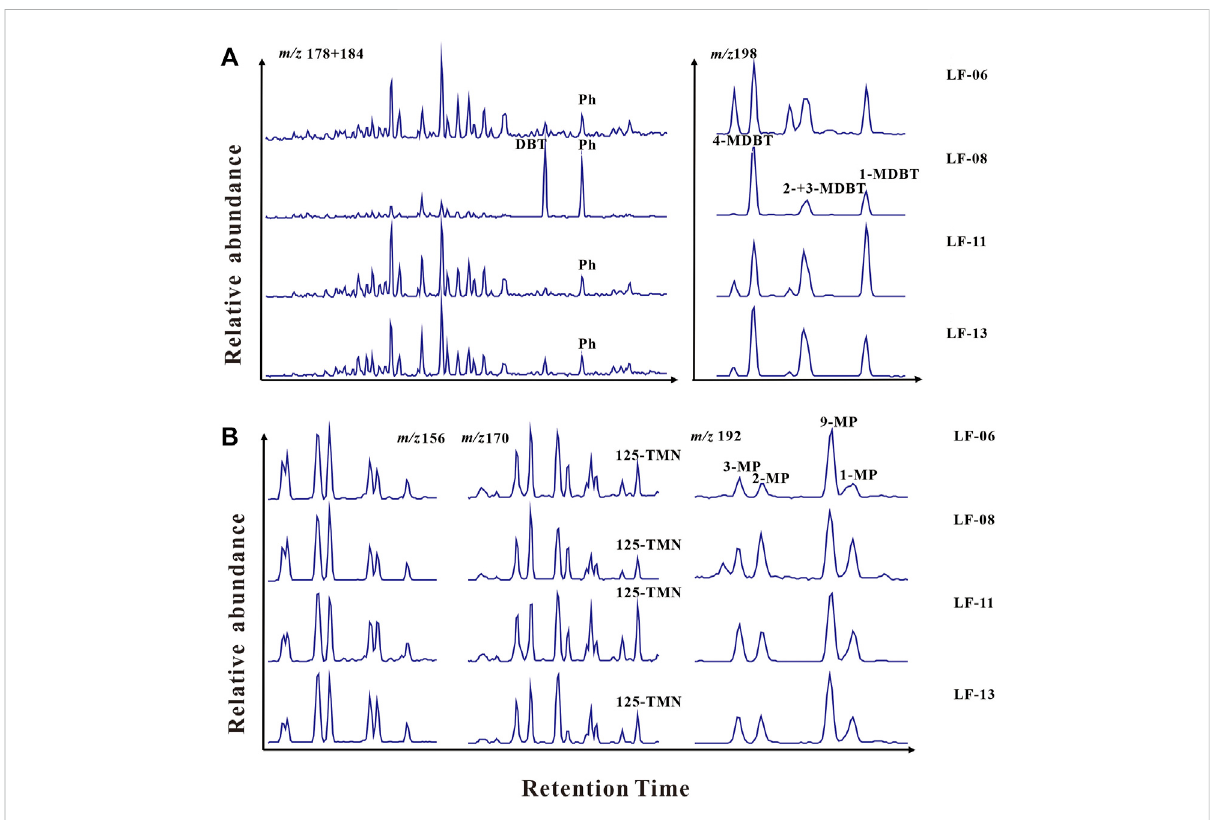
FIGURE 8 Standardbiologicalcompoundsofsamples2018-LF-006,2018-LF-008,2018-LF-011,and2018-LF-013. (A) Distributionofm/z178+184,and (B) aromatic distribution.